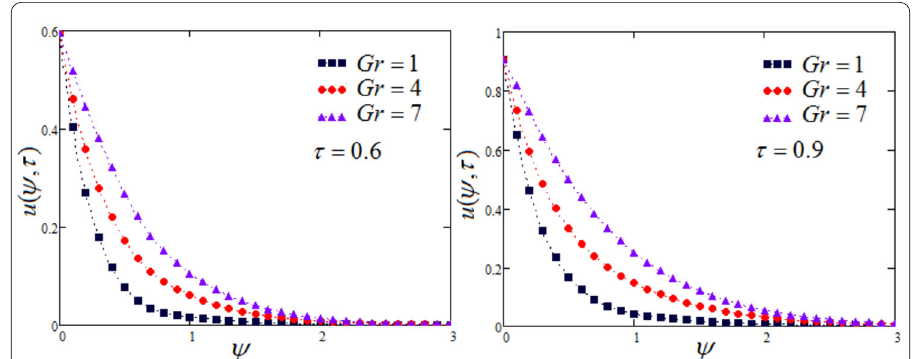
Figure 6 Velocity profiles of a Maxwell fluid for various values of Gr at two different times